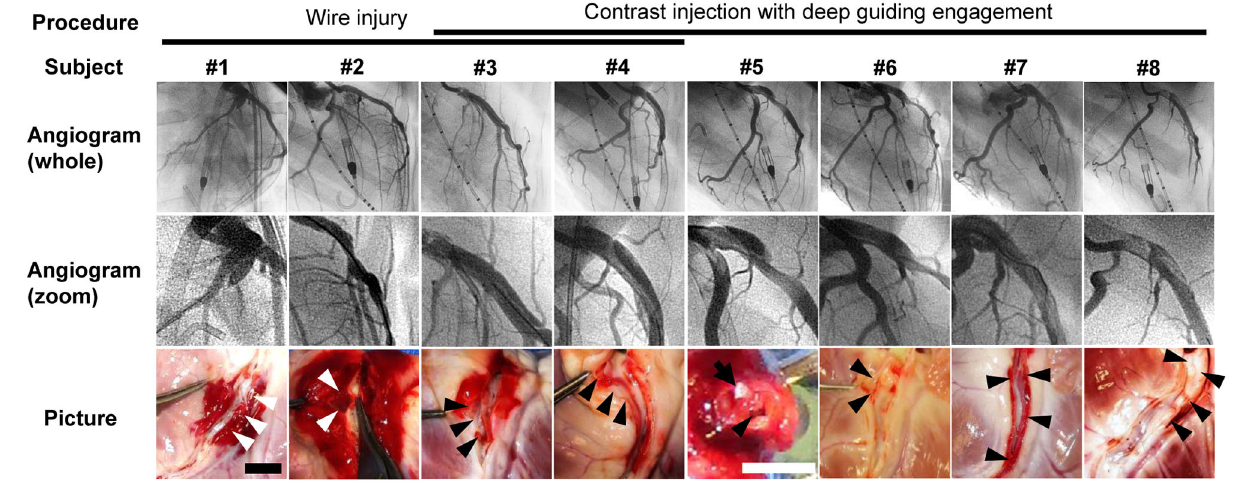
Frontiers in Cardiovascular Medicine |